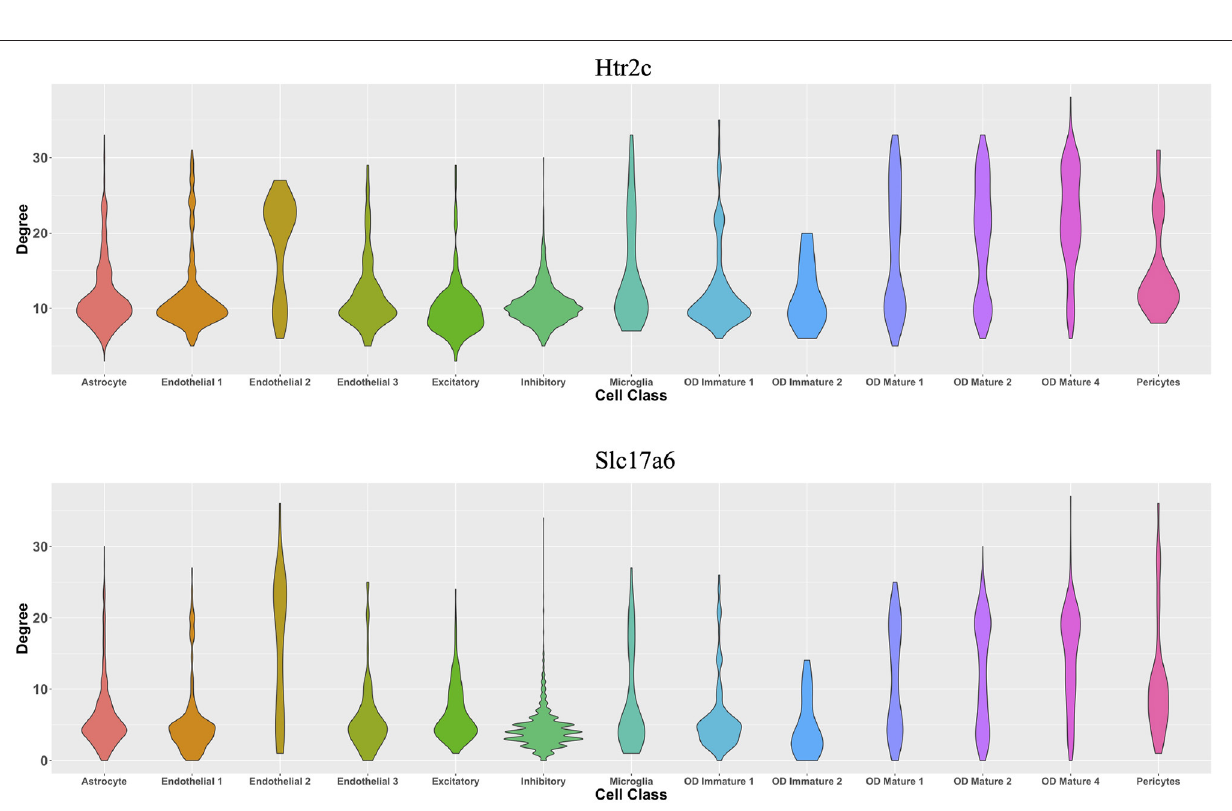
Frontiers in Genetics |